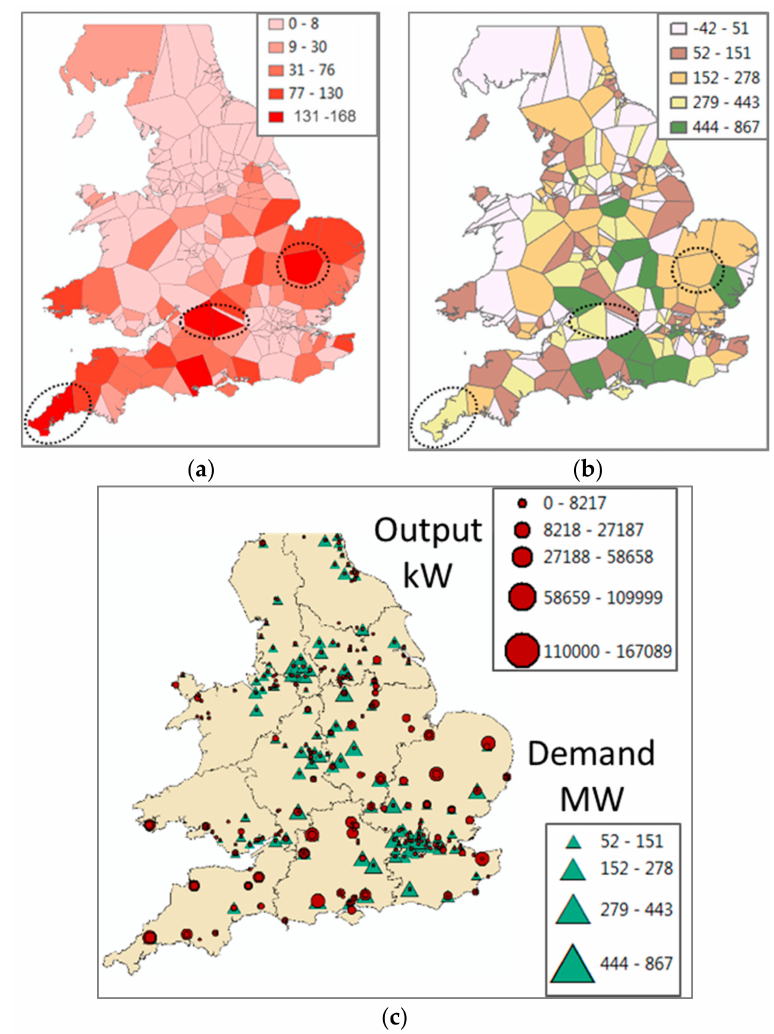
Figure 8. Calculated solar farm output in 2014 allocated to GSP area/point compared to electricity ten-year statement GSP winter peak demands 2015 (Demand data obtained from [19]. ( a ) Solar farm output allocated to GSP area MW 2014; ( b ) Demand per GSP area MW 2015; ( c ) Solar farm output and demand per GSP point (background DNO